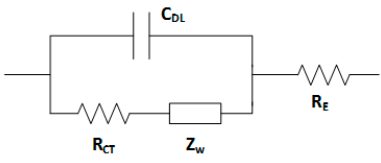
Figure 1. Randle’s circuit model [14].